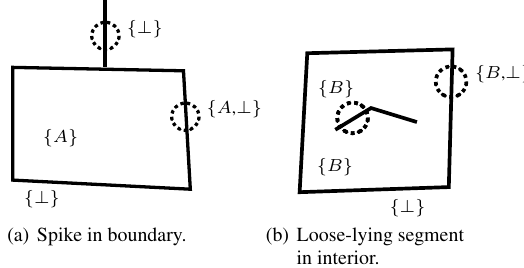
Figure 2: Degenerate cases will be prevented by correct